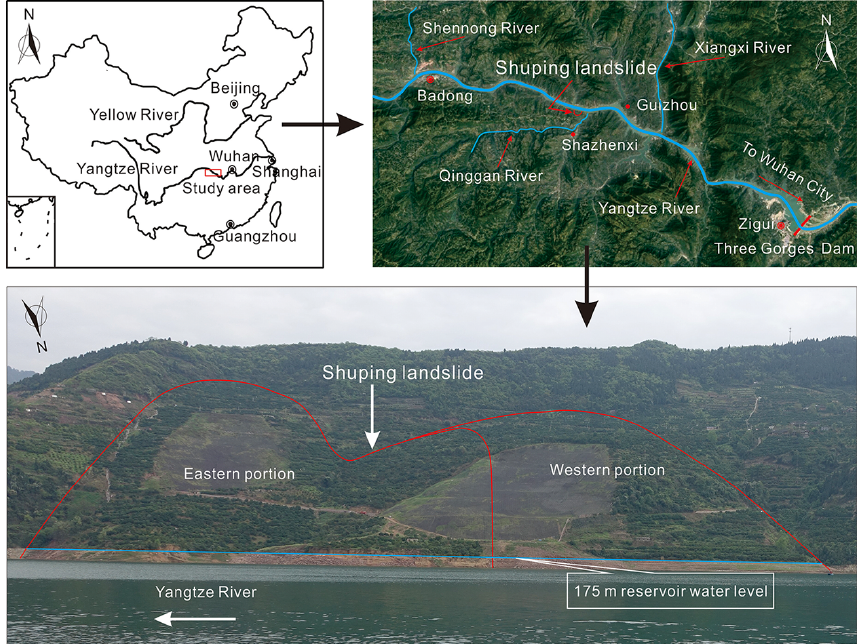
Figure 3. Location of the study area and panorama of the Shuping landslide and landslide